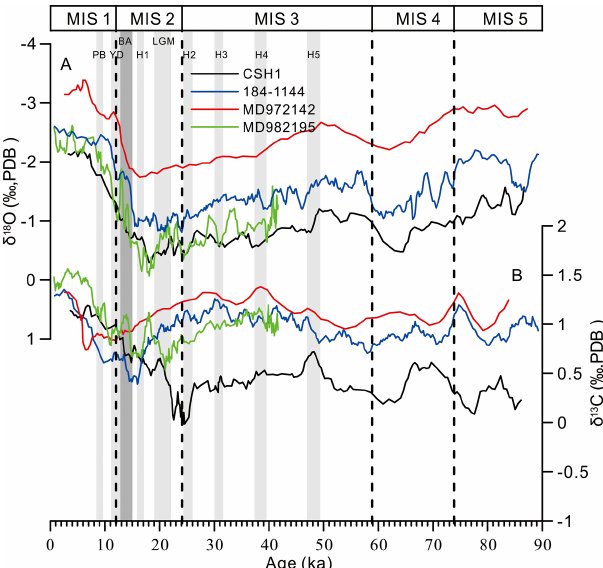
Figure 6. Time series plots of δ 18 O and δ 13 C of planktonic foraminifera, contrasted with the records in cores MD982195 (Ijiri et al., 2005), MD972142 (Chen et al., 2003) and Site 184–1144 (Buhring, 2001). Gray bars are the same as those in Fig. 4.